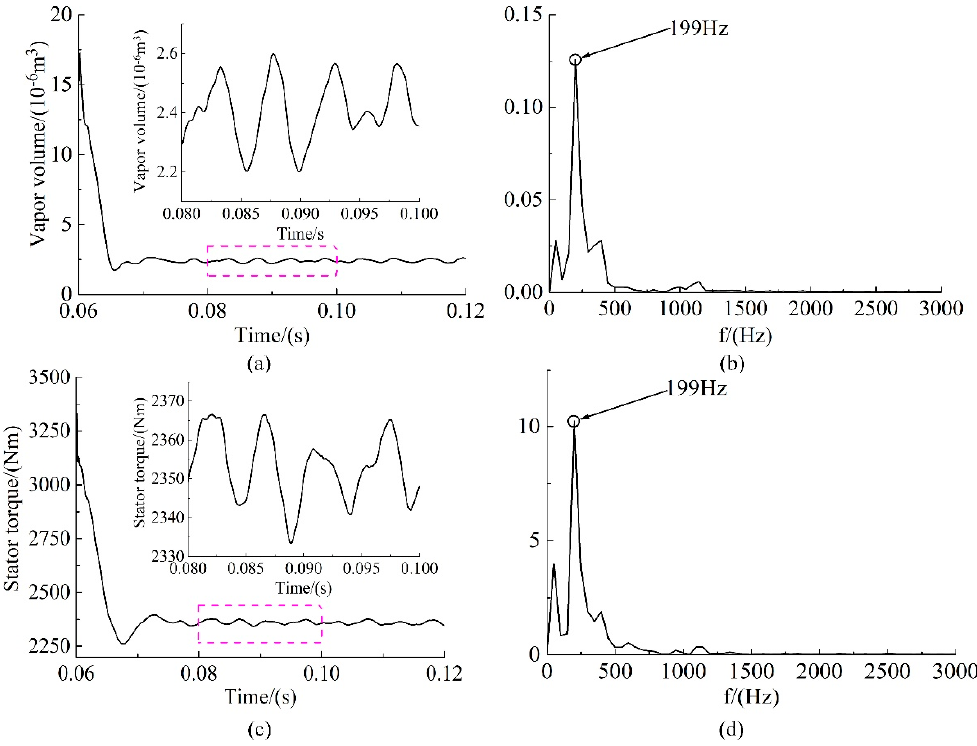
Figure 14. Variations in the vapor volume and torque of the stator in the time and frequency domains ( SR = 0): ( a ) vapor volume, ( b ) vapor volume spectrum, ( c ) torque, and ( d ) torque spectrum.